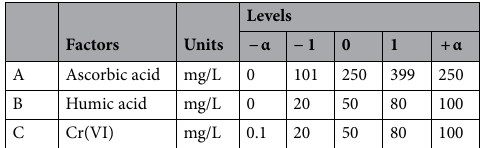
Table 1. Experimental factors and their levels for the reduction of Cr(VI) using ascorbic acid.